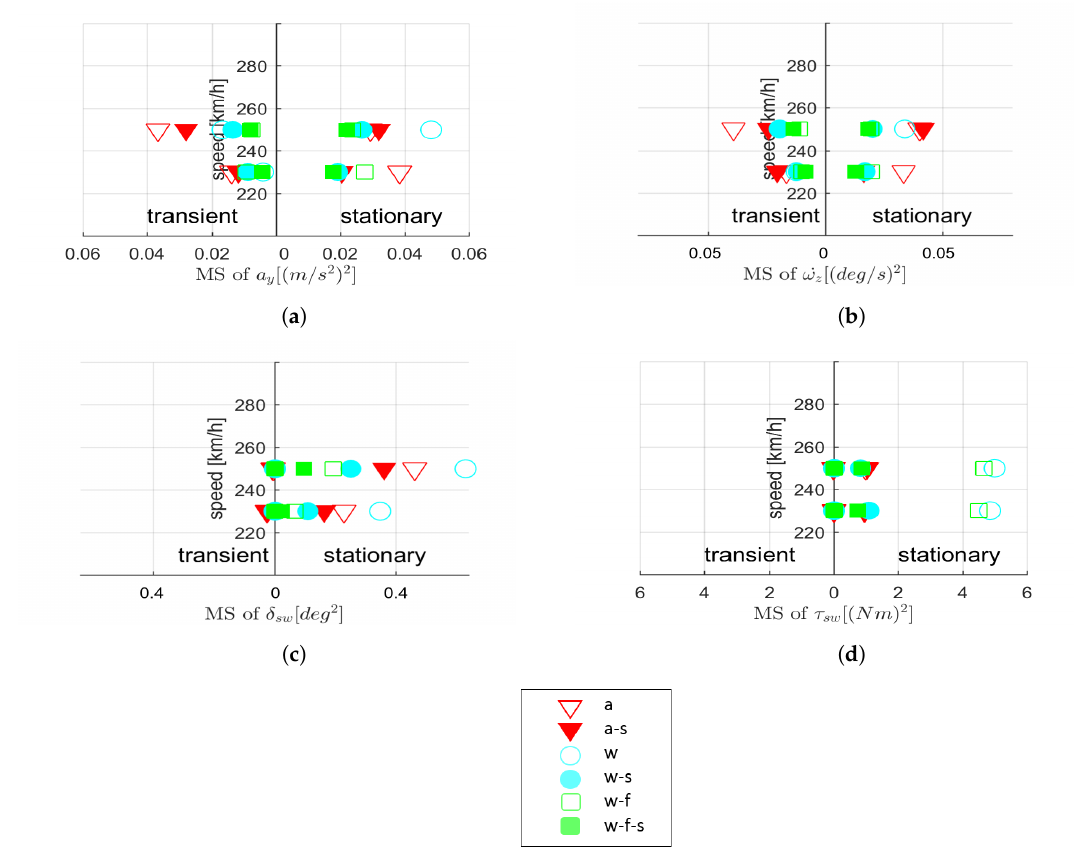
Figure 10. Ride diagram of all configurations and selected speeds: ( a ) Lateral acceleration a y . ( b ) Yaw velocity ˙ ω z . ( c ) Steering angle δ sw . ( d ) Steering torque τ sw